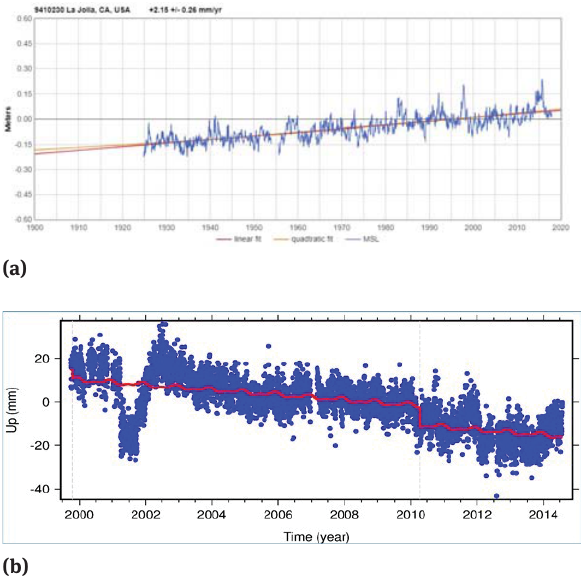
Figure 20: (a) MSL data for La Jolla, CA, USA. Image reproduced modified after [4]. (b) GNSS time series for SPW2. Image reproduced modified after NGL. This GNSS antenna is almost co-located with the tide